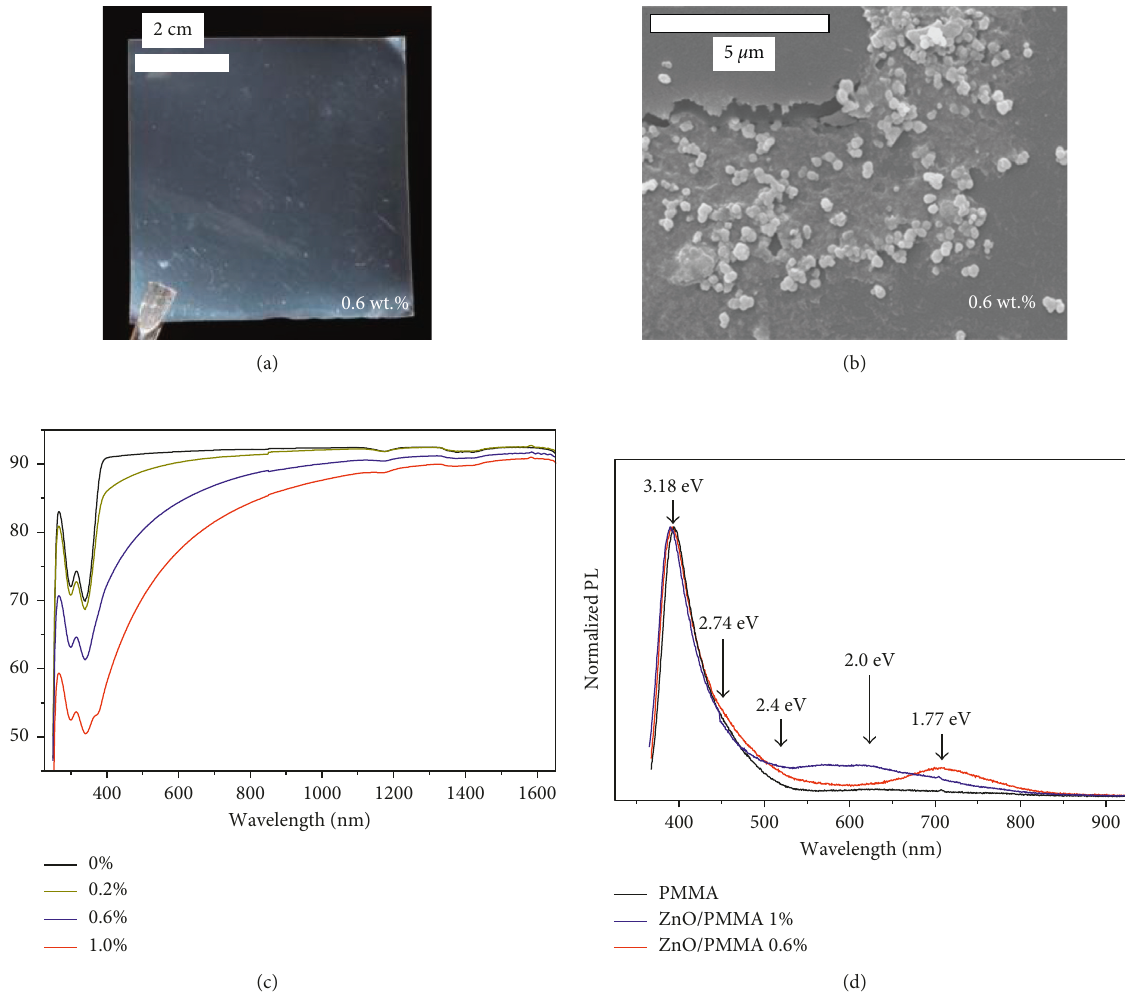
Figure 4: (a) A membrane picture; (b) SEM image; (c) UV-Vis absorption; (d) photoluminescence spectra of the ZnO-PMMA